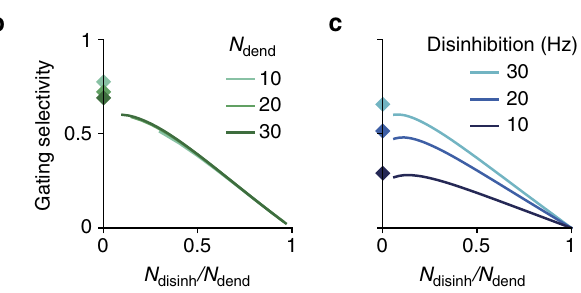
Figure 3 | Characterization of gating selectivity in pyramidal neurons. ( a ) Schematic of gating, presenting pathway 1 input when gate 1 is opened (left) or gate 2 is opened (right). There are N dend available dendrites in total. Each input pathway targets N disinh dendrites. To gate a pathway on, these exact N disinh dendrites are disinhibited, creating an aligned pattern of disinhibition. Each pathway selects dendrites randomly and independently from other pathways, which can result in overlap of the excitation– disinhibition patterns across pathways. When N disinh is large, projections from different pathways are more likely to overlap. The neuron’s firing rate is r on and r off in response to the preferred stimulus of the gated-on (left) and gated-off (right) pathway, respectively. The gating selectivity is defined as ( r on (cid:2) r off )/( r on þ r off ), which is 1 for perfect gating and 0 for no gating. ( b ) Gating selectivity increases as excitation/disinhibition patterns become sparser, that is, with a smaller proportion of targeted and disinhibited dendrites for a pathway ( N disinh / N dend ). Diamonds mark the case of non- overlapping excitatory projections, corresponding to the limit of maximal sparseness. ( c ) Gating selectivity is higher with stronger disinhibition, for all sparseness